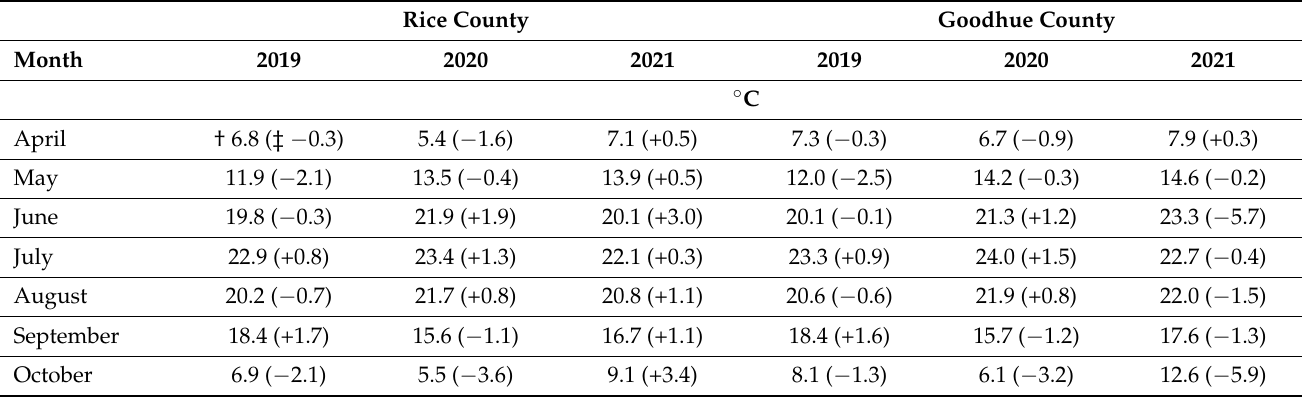
Table 2. Monthly temperature data and departures from normal during the 2019, 2020, and 2021 growing seasons for the Rice * and Goodhue Counties, MN,